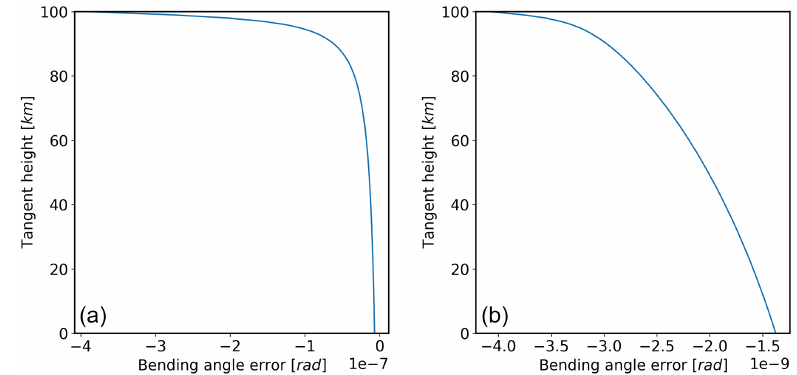
Figure 4. Bending angle residual errors for test 1 ( a , midday) and test 2 ( b , midnight).